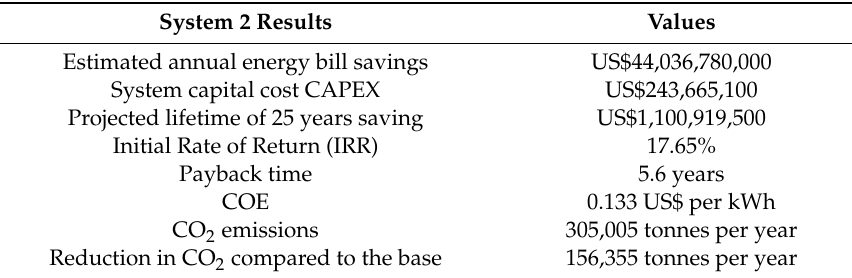
Table 4. Zagazig optimal proposed